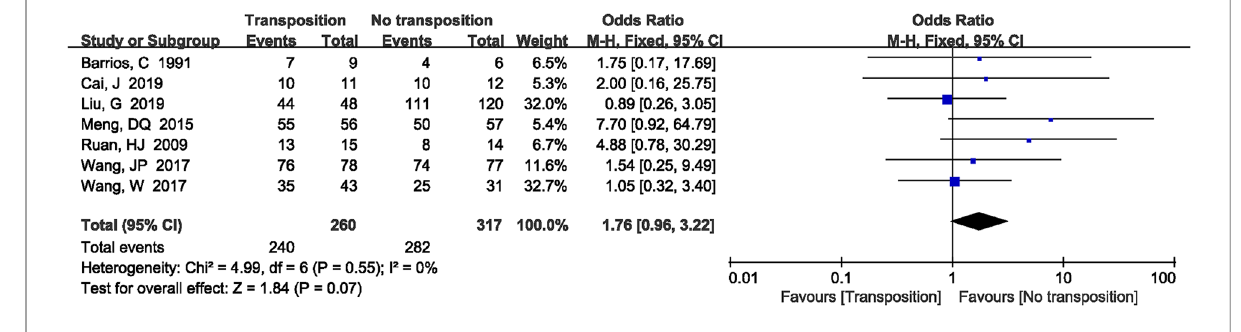
FIGURE 8 A forest plot showing the elbow joint function.